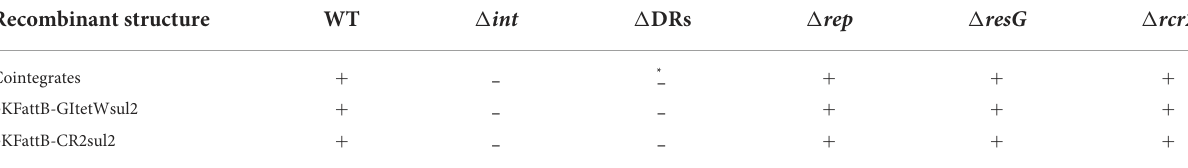
TABLE 2 Effect of deleting GI sul2 -associated regions on integrations. Recombinant